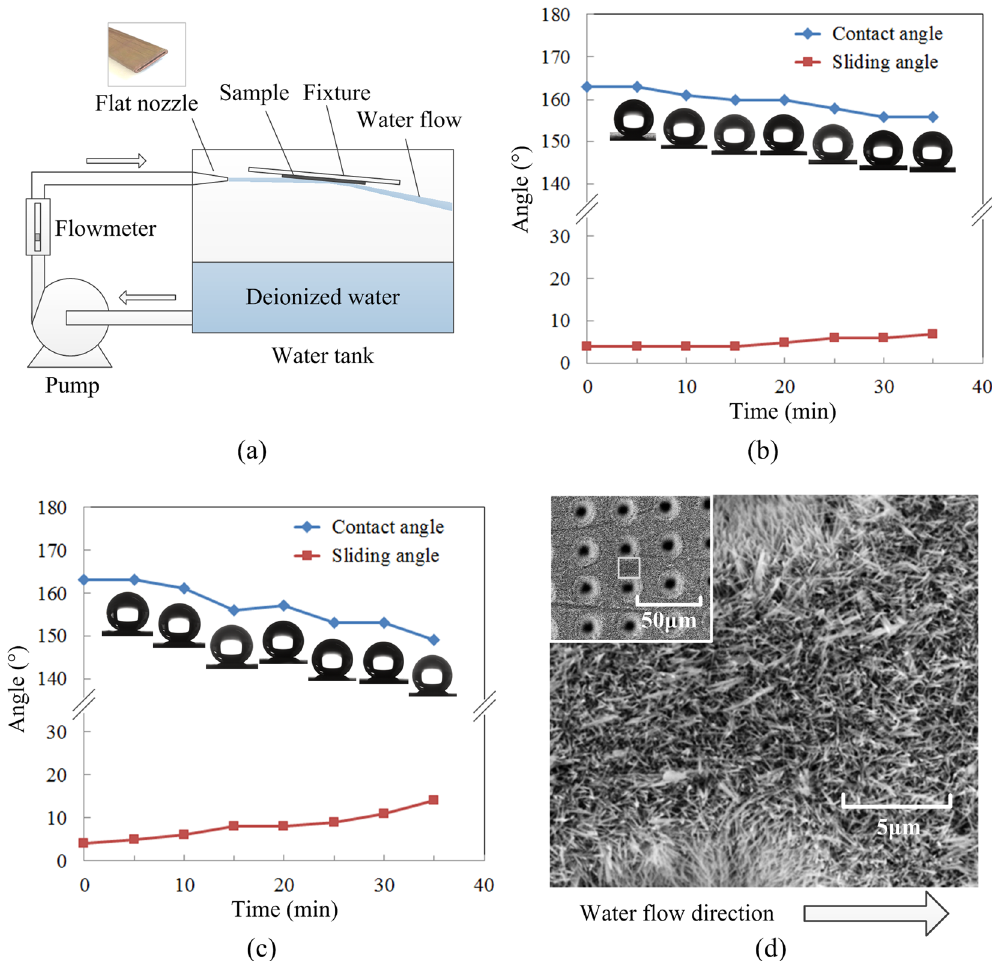
Figure 7. ( a ) Schematic illustration of water flow scouring test employed to evaluate the mechanical durability of the processed surface. ( b,c ) Evolutions of contact angle and sliding angle with water flow scouring time at 4m/s and 6m/s flow rate respectively. ( d ) SEM image showing the morphology of the surface after water flow